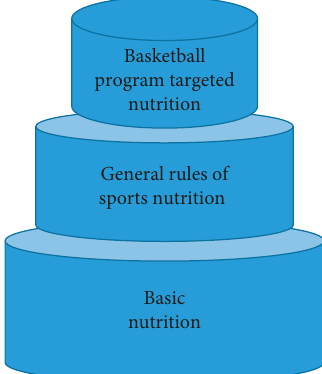
Figure 2: The composition of nutritional support for basketball